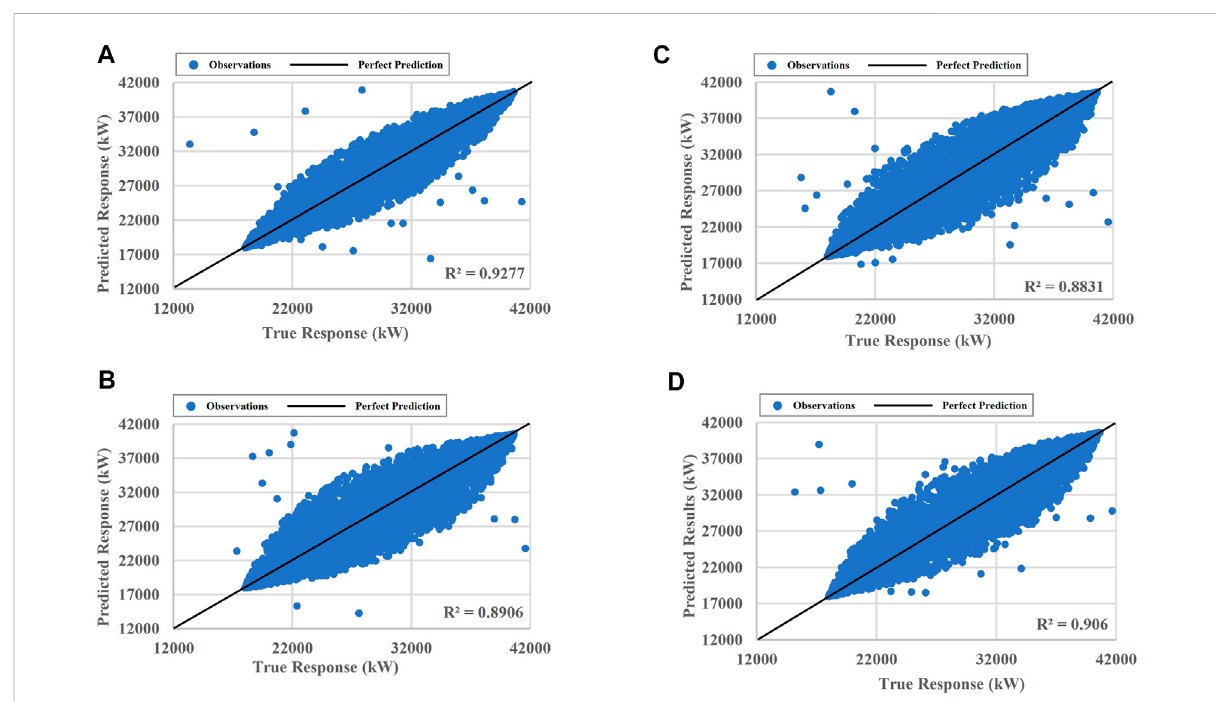
FIGURE 6 R-squared plots of (A) proposed method, (B) Bayesian LSTM. (C) Bayesian Bi-LSTM and (D)